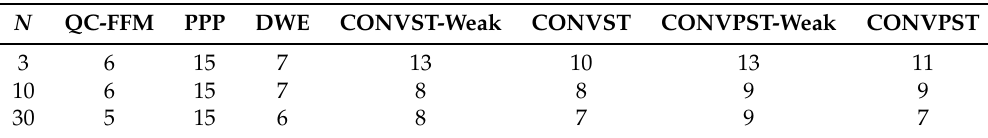
Table 5. n ∗ for the different codes as a function of the electron density N , expressed in units of 10 17 e/cm 3